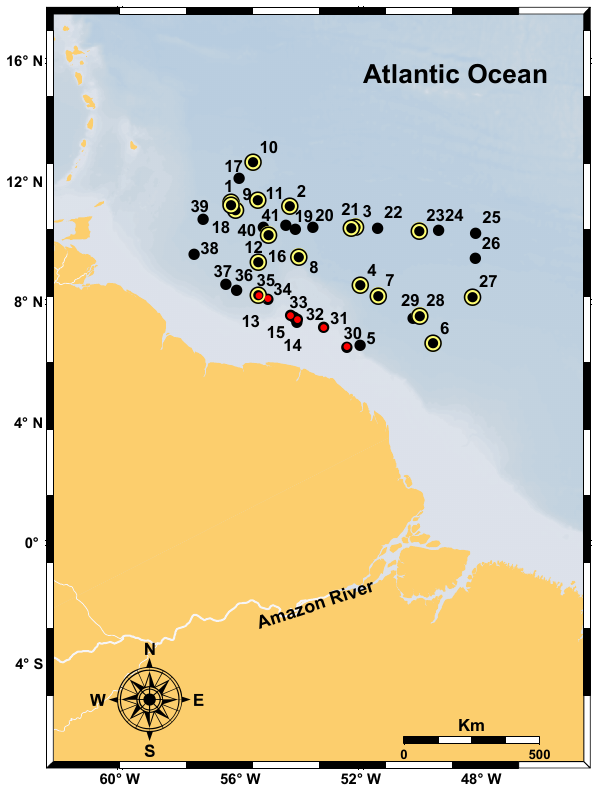
Fig. 1. Sampling location: water samples (black circles), Tri- chodesmium colonies (yellow circles) and 24-h tidal cycling (red circles)